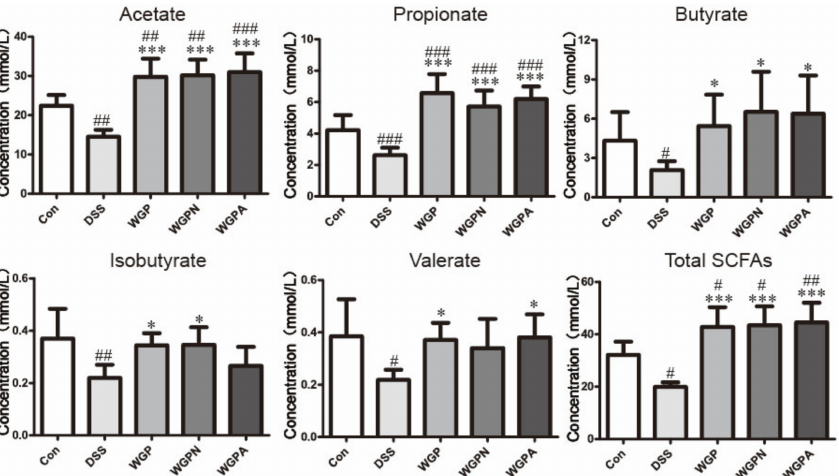
Figure 5. SCFA content in the feces of rats. The bars represent the mean ± SD, n = 8; # p < 0.05, ## p < 0.01, ### p < 0.001 compared with the con group; * p < 0.05, *** p < 0.001 com- pared with the DSS group. Con, control group; DSS, colitis group; WGP, WGP treatment group; WGPN, WGPN treatment group; WGPA, WGPA treatment